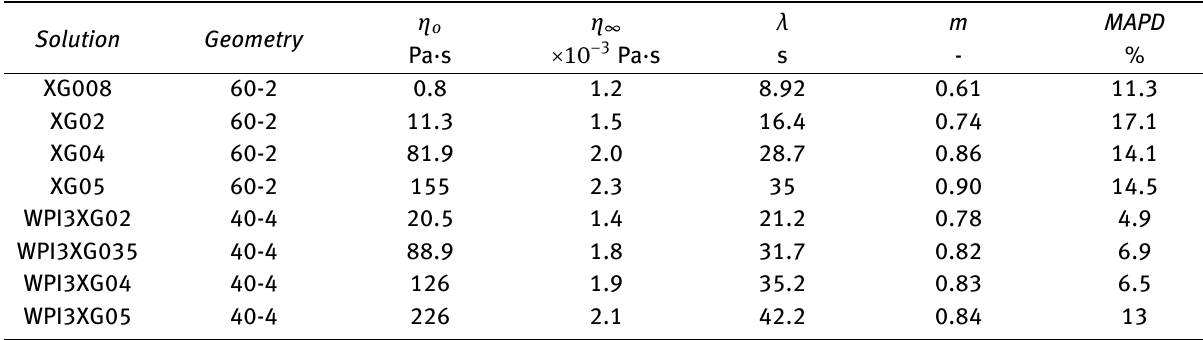
Table 4: rheological variables of the model fits used in Figure 6 and mean absolute percent deviation between experimental data and model fit (MAPD)